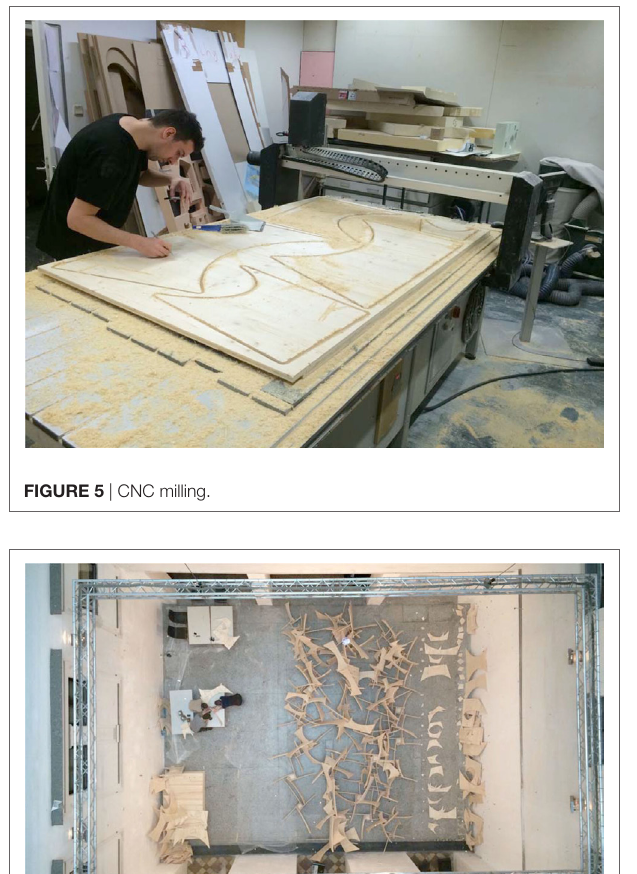
FIgURe 6 | The production pipeline of pre-assembly.